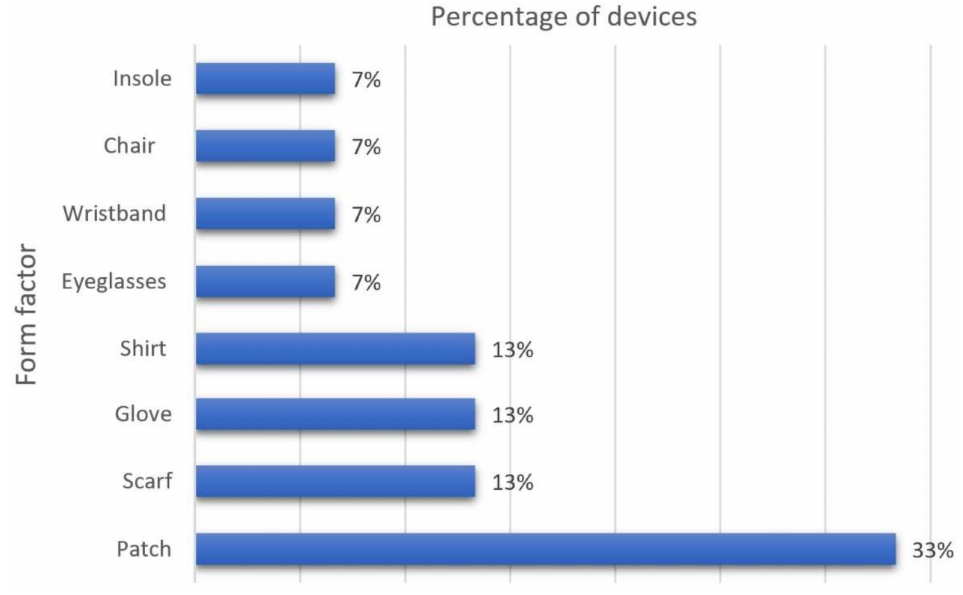
Figure 7. Classification of Non-Commercial Wearables by Form